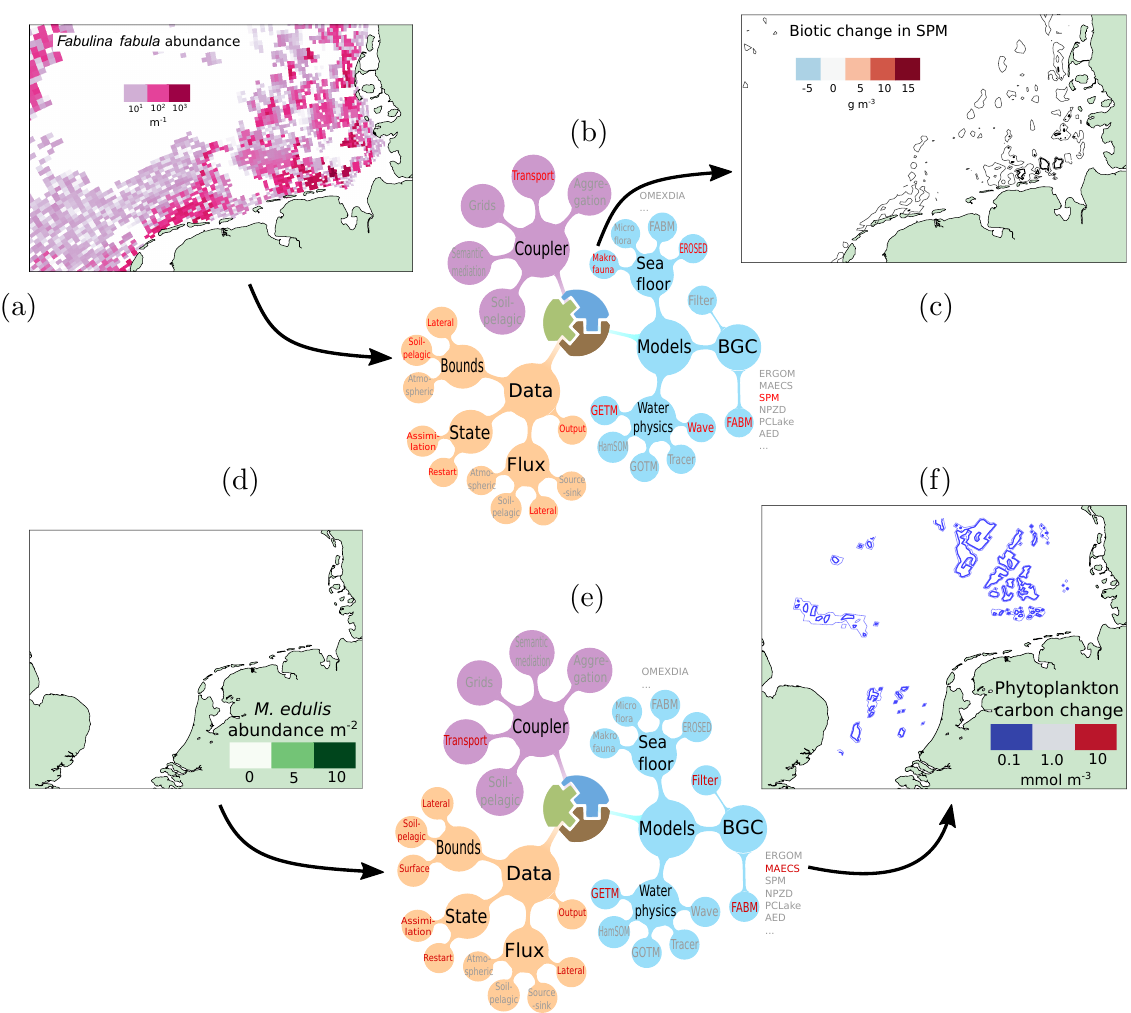
Figure 7. Building flexible applications with MOSSCO. Two bivalve-related scientific applications are showcased: Nasermoaddeli et al. (2018) investigated the effect of bottom-dwelling Fabulina fabula ( a , showing parts of the southern North Sea) on suspended sediment concentration (c) with a coupled application integrating hydrodynamics, three pelagic SPM classes in the ecosystem model, the mediation of erodibility by benthic bivalves, and an explicit description of bed erosion and sedimentation (b) ; see Sect. 4.4 and Fig. 5. Slavik et al. (2018) investigated the effect of epistructural Mytilus edulis (d) on phytoplankton concentration (f) with a coupled application integrating hydrodynamics, the FABM–MAECS ecosystem model, and filtration by mussels (e) .